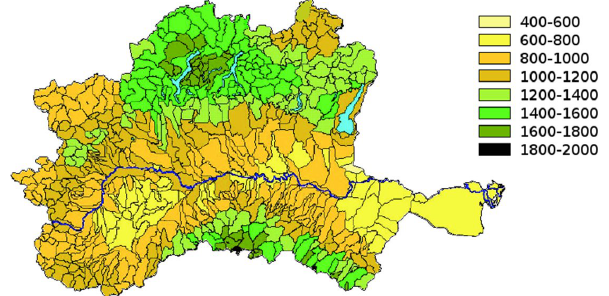
Fig. 2. Mean annual rainfall over the Po River basin (from Po River Basin Authority,